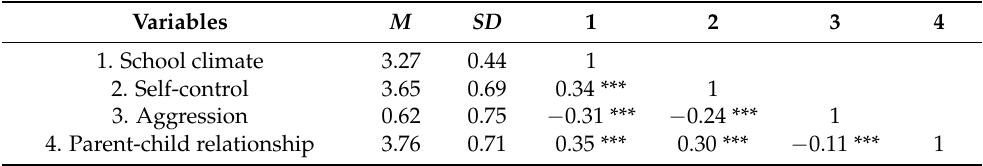
Table 1. Descriptive statistics and correlations among variables.